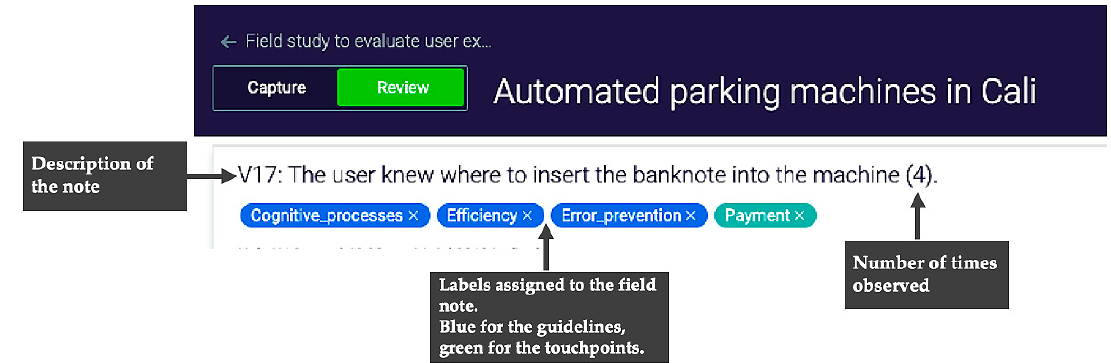
Figure 15. Screenshot of a field note logged in Reframer that corresponds to observations made of the automated parking machines in Cali. Guideline tags (in blue) and touchpoint tags (in green). Observations frequency is made is logged in brackets.